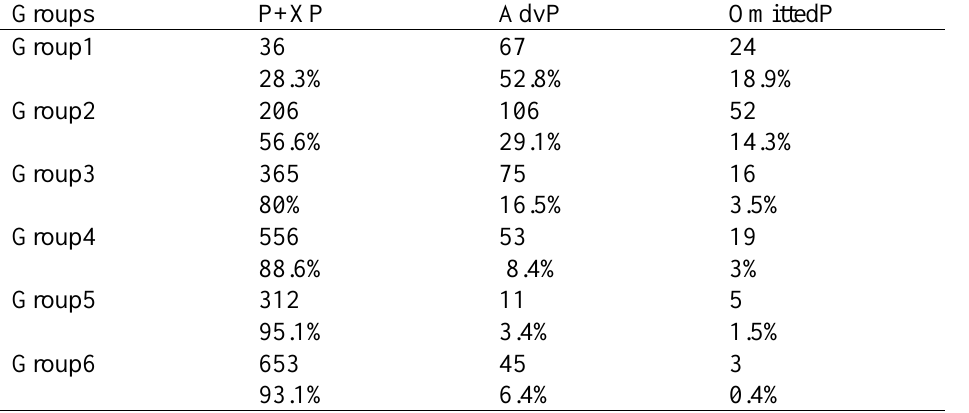
Table 4. Overview of the occurrences: P+XP, AdvP, OmittedP across MLU groups